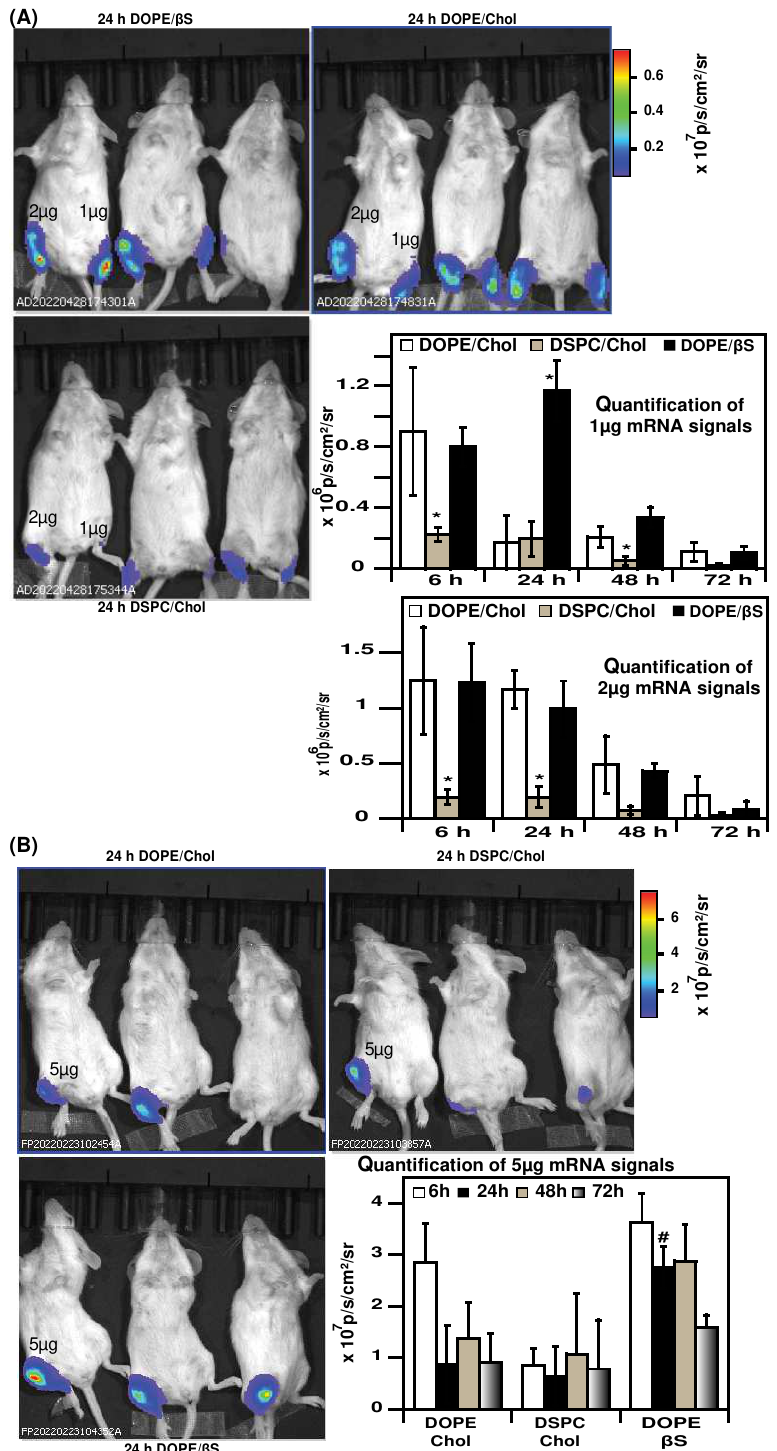
Figure 4. Evaluation of mRNA LNPs in vivo expression: ( A ), representative images of luciferase expression 24 h after intramuscular injection of 1 µ g or 2 µ g mRNA-LNPs, signal was during 3 days ( n = 3); ( B ), representative images of luciferase expression 24 h after intramuscular injection of 5 µ g mRNA-LNPs, signal was during 3 days ( n = 3). Data are presented as mean ± SD, * p < 0.05 compared to DOPE/Chol LNPs and DOPE/ β S LNPs, # p < 0.05 compared to DOPE/Chol and DSPC/Chol